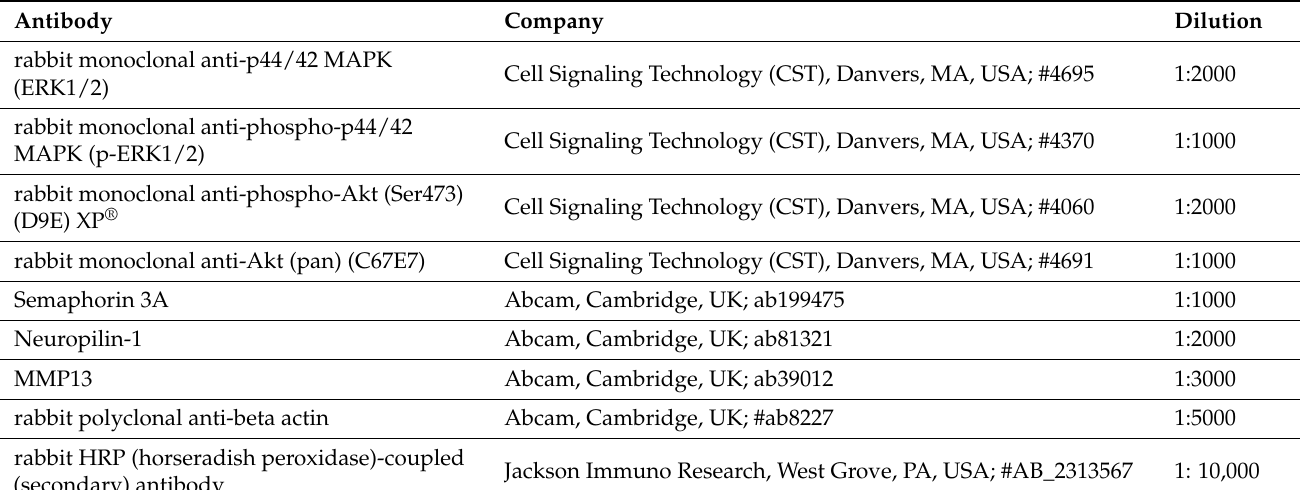
Table 2. Primary and secondary antibodies used in this